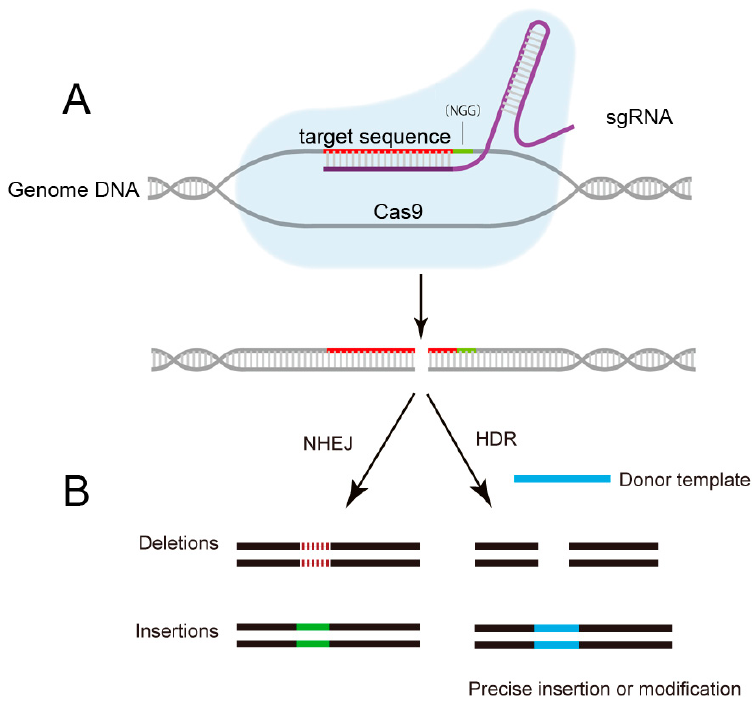
Figure 2. Schematic of CRISPR/Cas9 mediated-genome editing. ( A ) The sgRNA guides the Cas9 protein to cut specific DNA sequence by recognizing the protospacer-adjacent motif (PAM) sequence and a complementary target sequence; ( B ) The breaks induced by Cas9 are repaired either through homology-directed repair (HDR) or non-homologous end joining (NHEJ), results in precise gene editing with insertions or deletions (indels), respectively. NGG: PAM sequence.